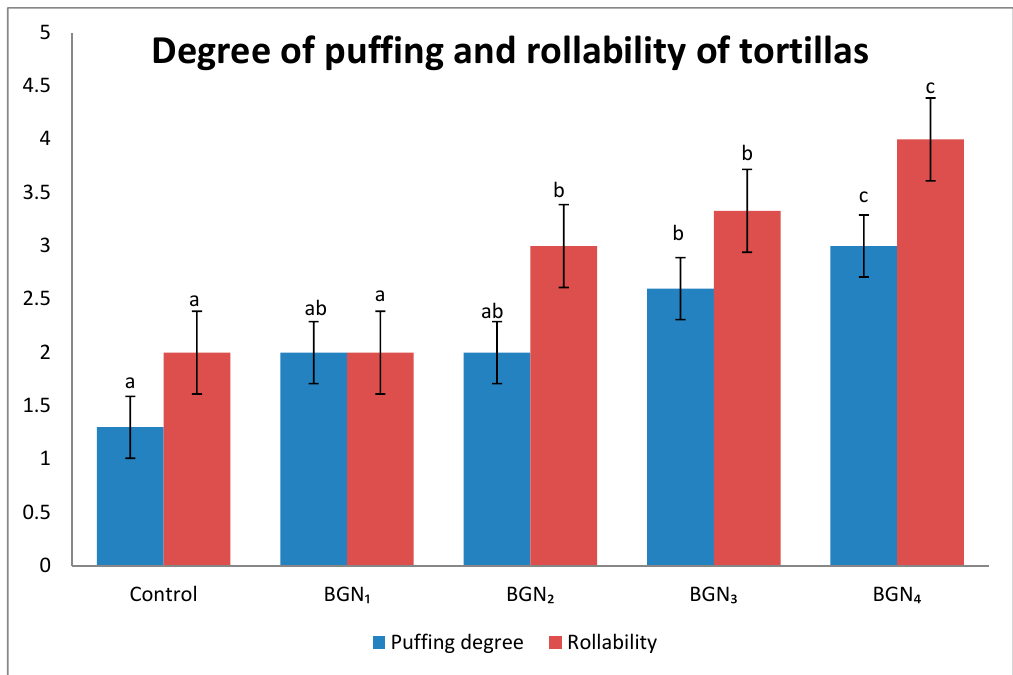
Figure 1. Quality properties of tortillas added with Bambara groundnut flour. BGN 1 , BGN 2 , BGN 3 and BGN 4 refer to the tortillas prepared from Bambara groundnut and maize flour (BGN: maize) in the percentages of 5:95, 10:90, 15:85 and 20:80 and maize flour was used as control. Different alphabets on bars indicate statistically different effect ( p ≤ 0.05).